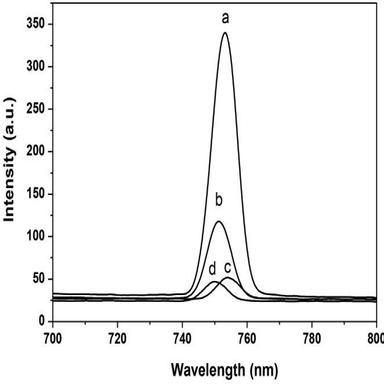
Fluorescence spectra (films) of P3HT-MWCNT prepared by click chemistry: (a) P3HT; (b) physical blends of P3HT and 50 wt% MWCNT; (c) physical blends of P3HT and 80 wt% MWCNT; (d) P3HT-MWCNT.